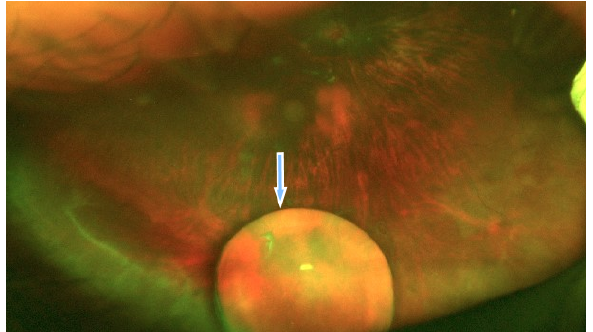
Figure 2: Fundus photograph of the right eye with the lens in the vitreous cavity